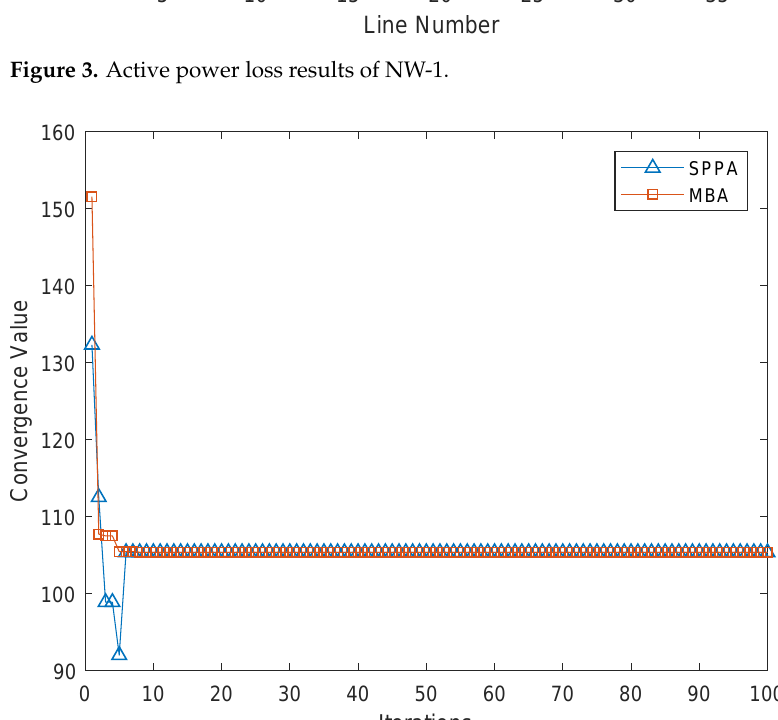
Figure 4. Algorithm convergence for